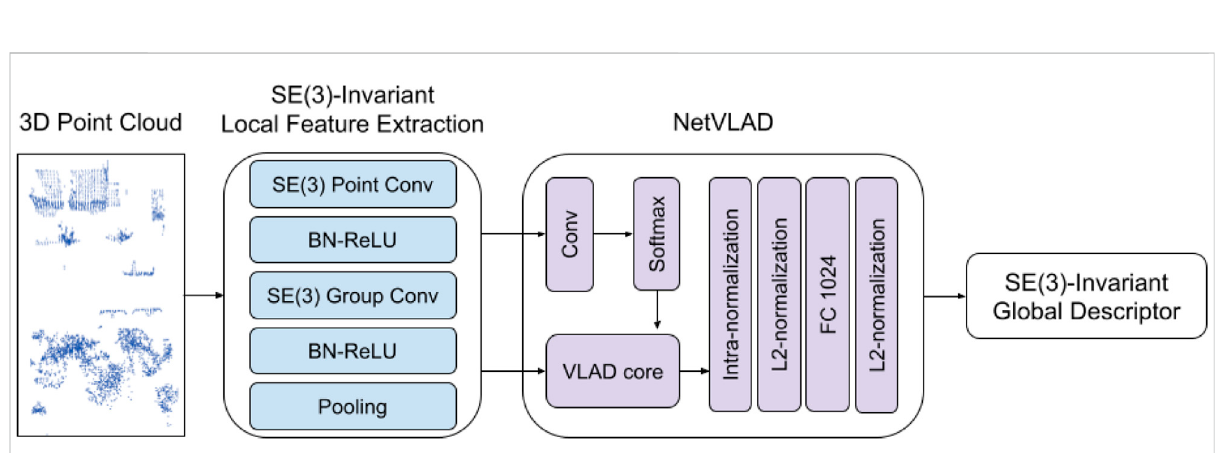
FIGURE 15 Overview of the SE(3)-invariant place recognition network. In this network, SE(3)-invariant features are learned from input point clouds. The local feature extraction consist of SE(3) point convolution, SE(3) group convolution, batch normalization followed by leaky ReLU activation,